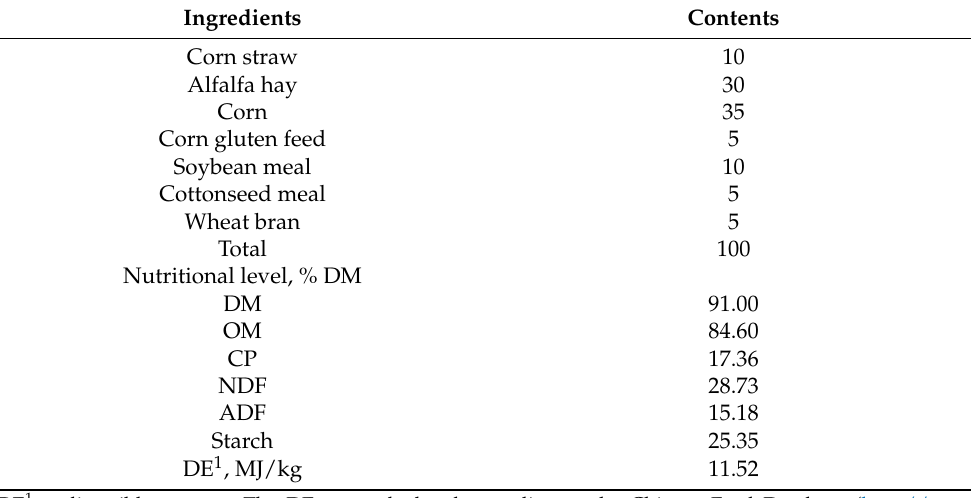
Table 2. Composition and nutritional level of diets (%).